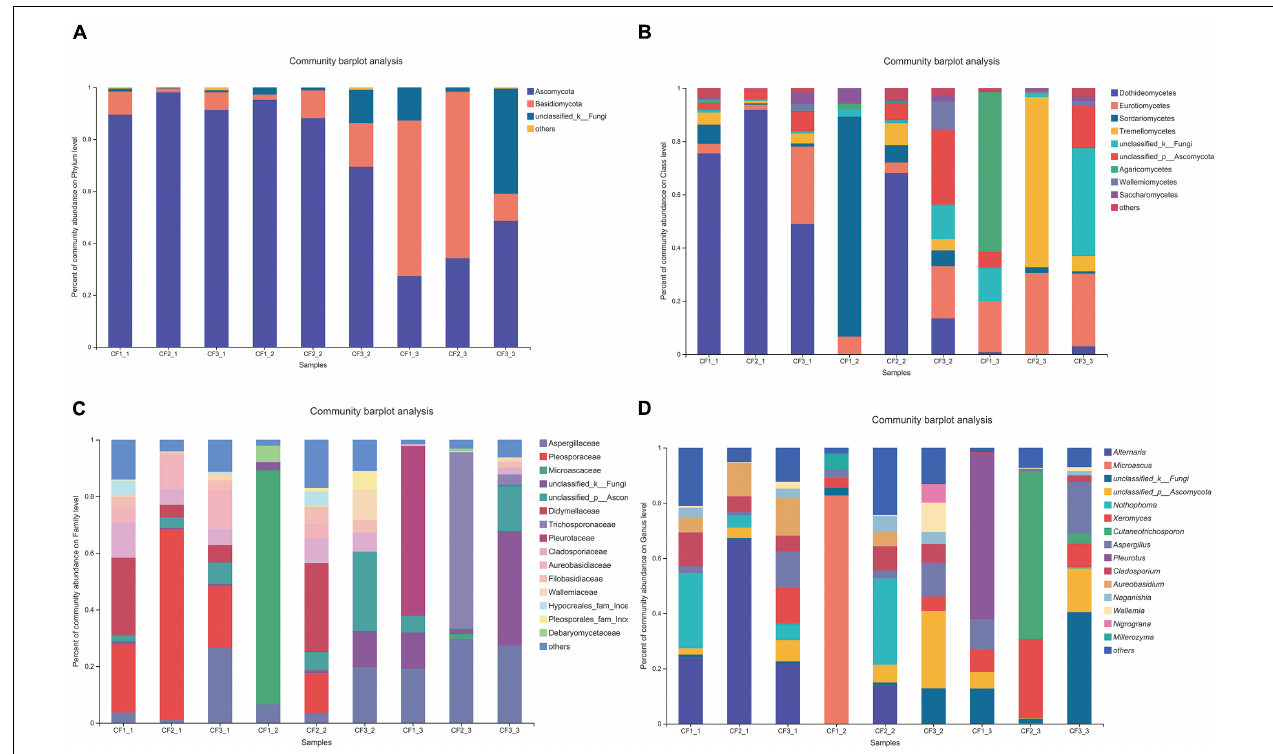
FIGURE 4 | Fungal composition in various processed CF samples at the (A) phylum level, (B) class level, (C) family level, and (D) genus